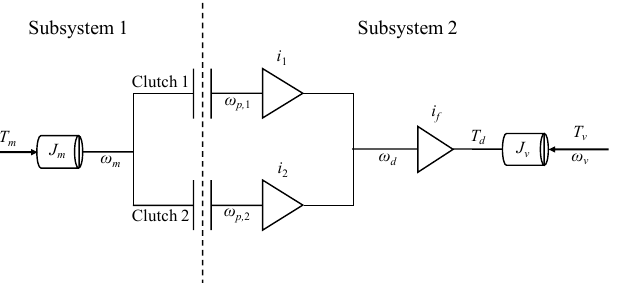
Figure 2. Simplified powertrain model: ω p ,1 is the rotation speed of primary part of the first gear, T m is the output torque of hydraulic motor, T d is the drive torque on the wheels, T v is the resistant force, and J m is the rotational inertia of the hydraulic